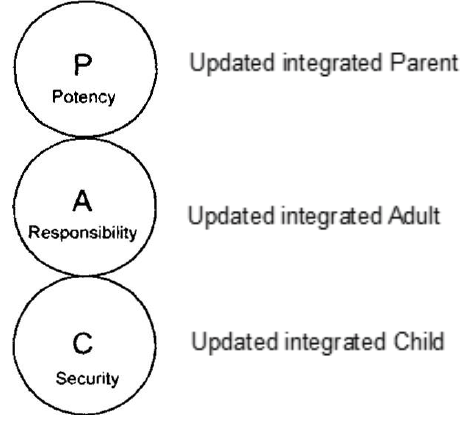
Figure 15: An Altruistic Model of Ego States (Drego, 2006, p.99)